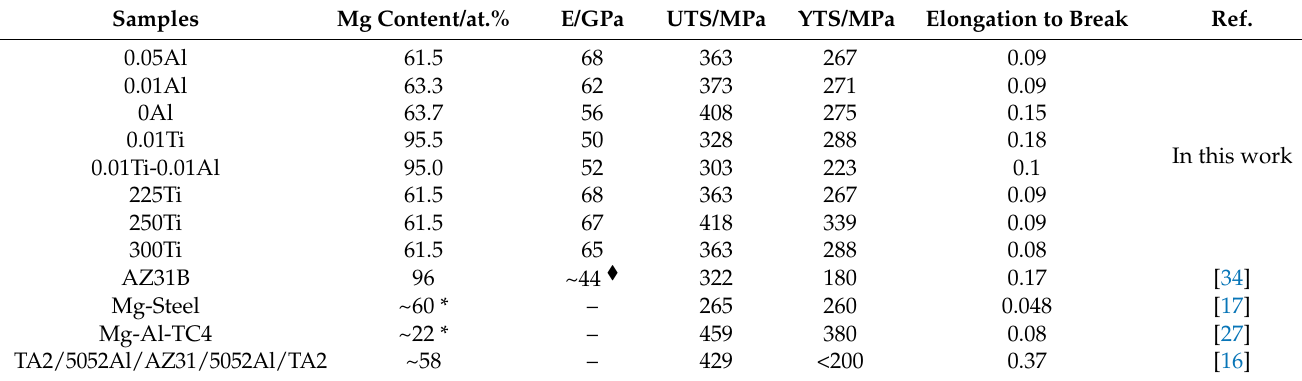
Table 6. Mechanical properties of Mg-(Al-)Ti rolled sheets after heat treatment and other reported Mg-based composite rolled sheets.